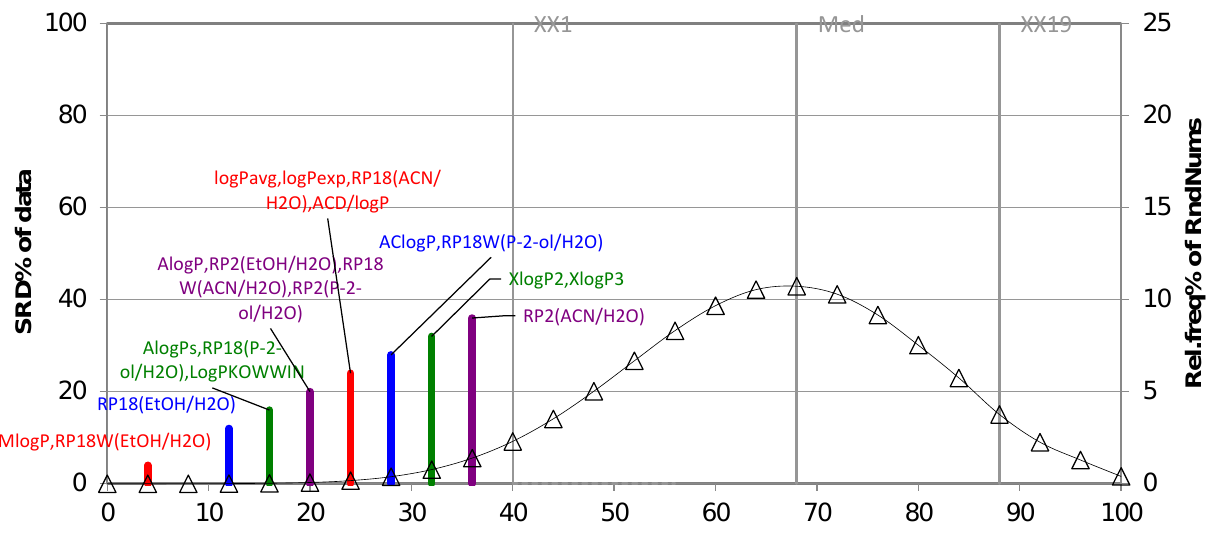
Figure 7. SRD analysis of both; chromatographically obtained and theoretical values of lipophilicity descriptors of studied compounds.